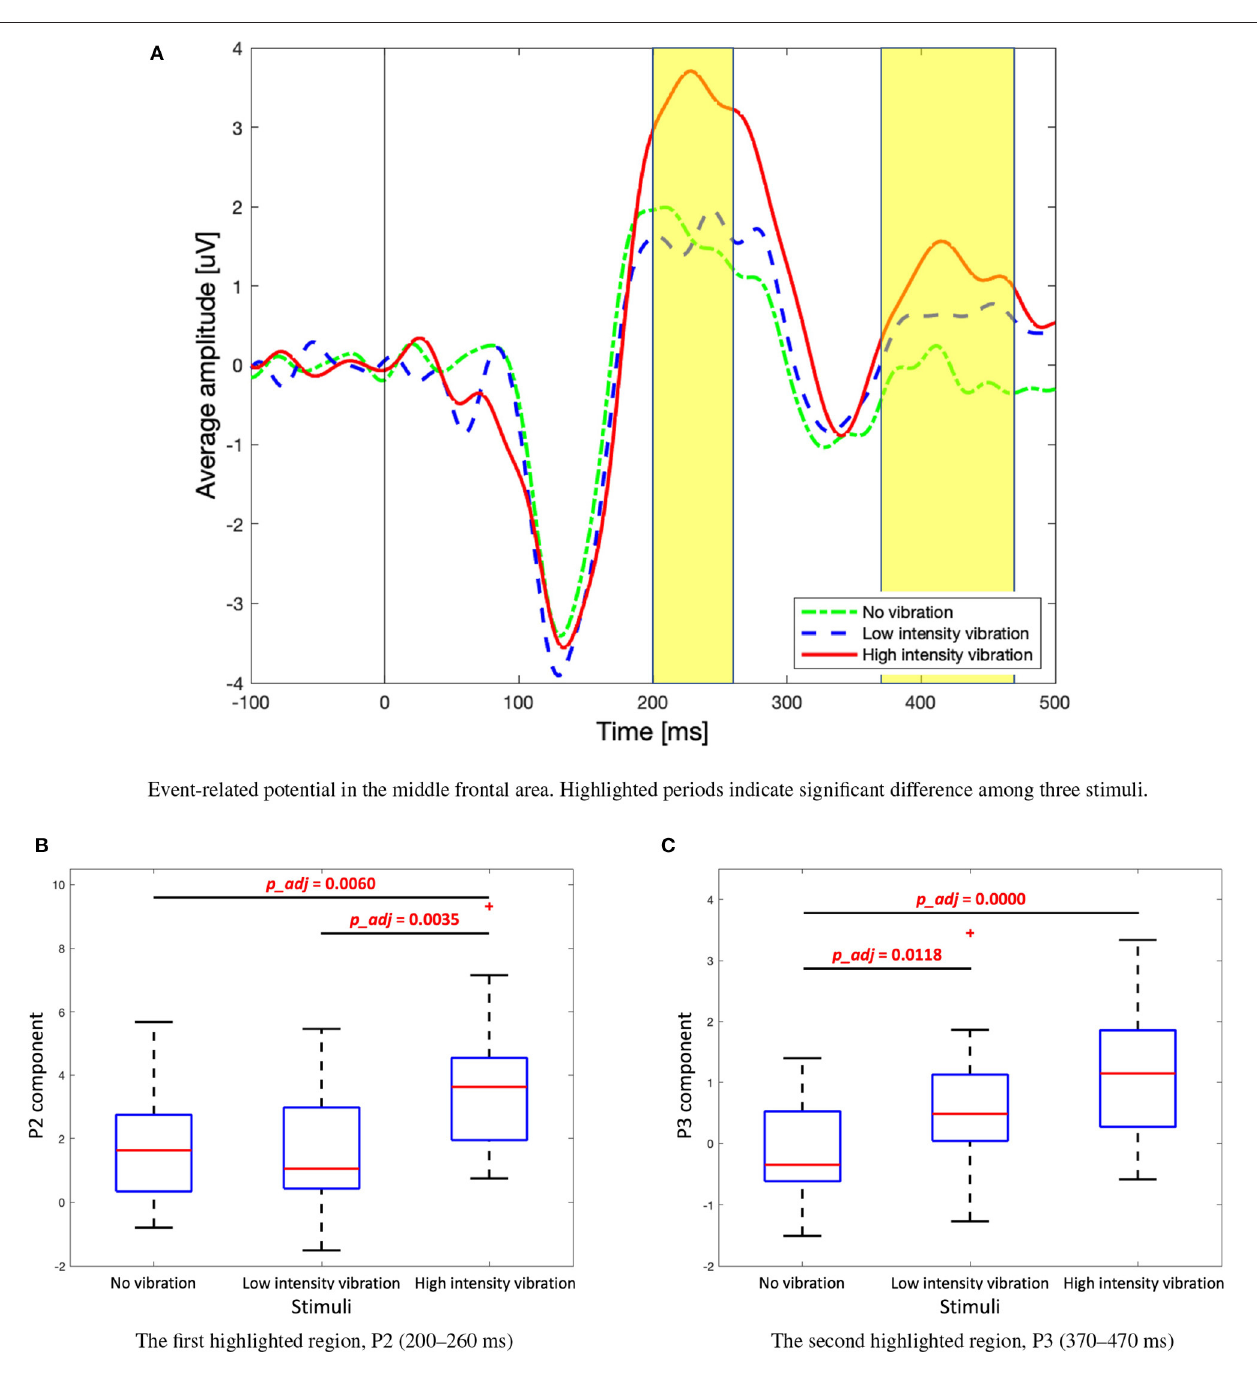
FIGURE 8 | (A) Event-related potential, P2, and P3 components in the middle frontal area (Fz). (B) Box plots to show significant differences in P2 component among three stimuli. Kruskal–Wallis test, H (2) = 14.41, Holm–Bonferroni correction. (C) Box plots to show significant differences in P3 component among three stimuli. One-way analysis of variance (ANOVA), F (2,86) = 13.4, Holm–Bonferroni